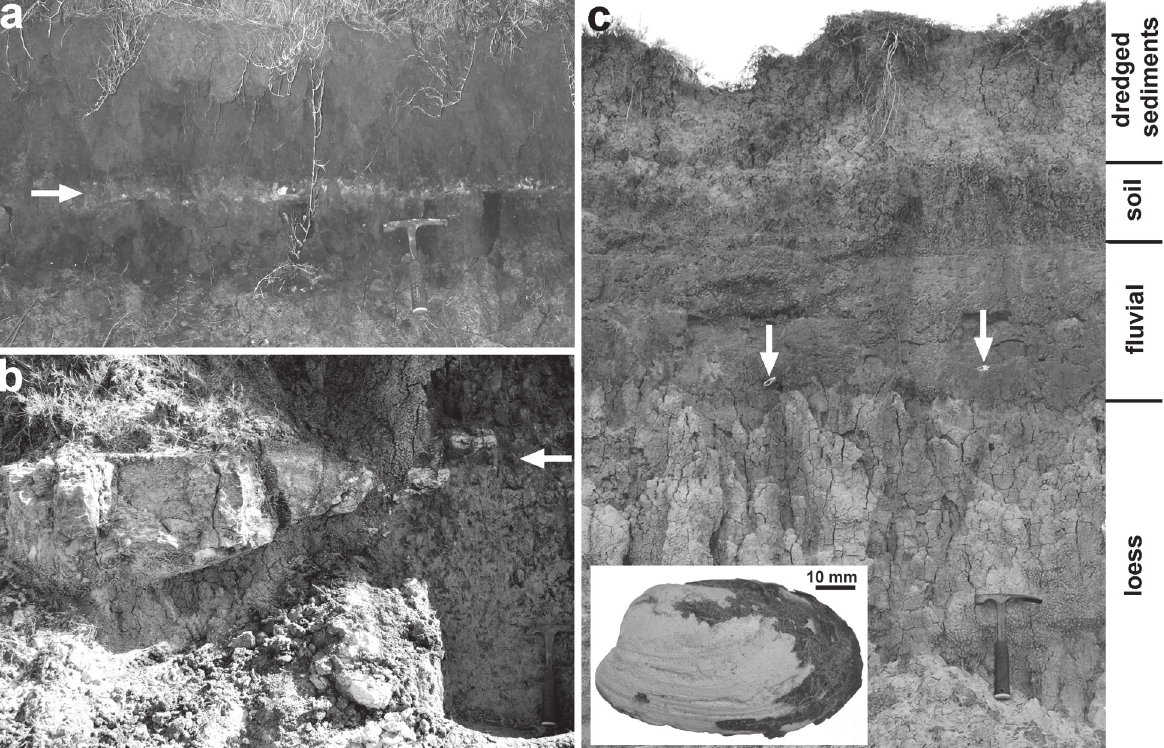
Figure 7 - a: Diatomite layer (the light-colored streak pointed by the arrow) within the upper Cordão Formation. b: Diatomite body (the lenticular white structure on the left of the photo) outcropping on the right bank, at the boundary (pointed by the arrow) between the lower and upper Cordão Formation. c: Detail of the right bank of Chuy Creek, showing the erosive boundary between the Pleistocene loess below and a Holocene fluvial system. The arrows indicate a fragmented bone (on the left) and one articulated bivalve Diplodon (on the right, also shown on the